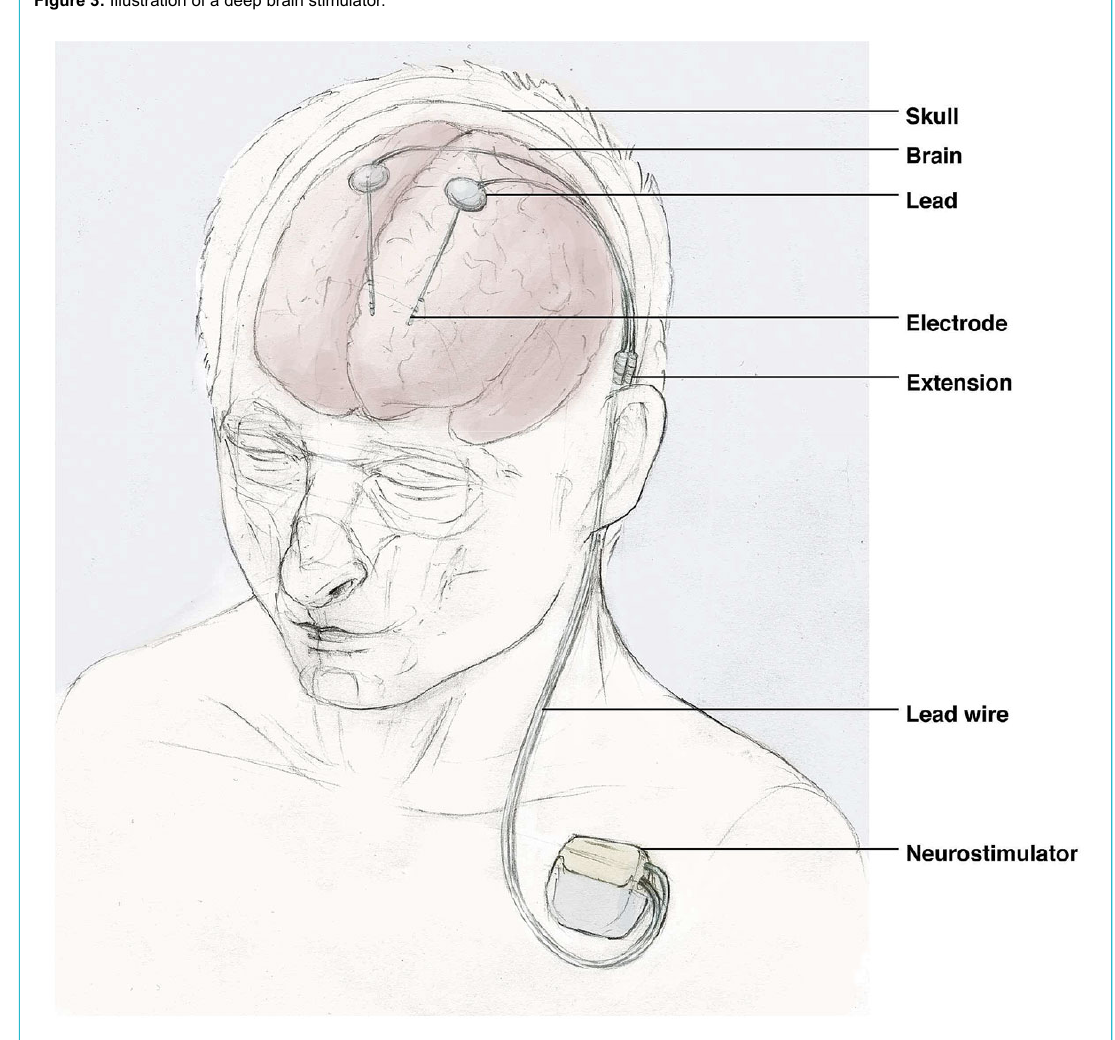
Figure 3: Illustration of a deep brain